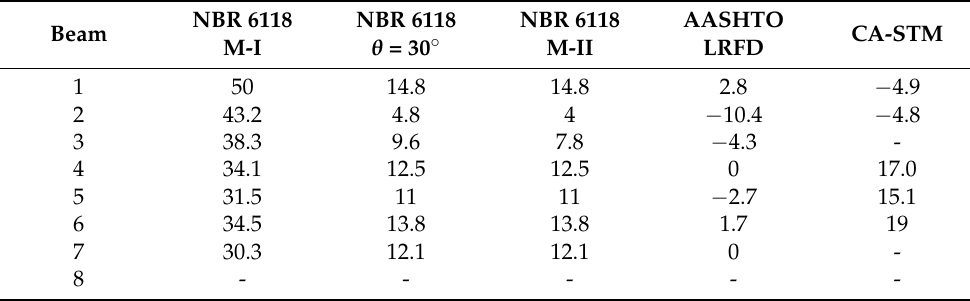
Table 5. Relative errors (%) for the maximum torques for RC beams from Series